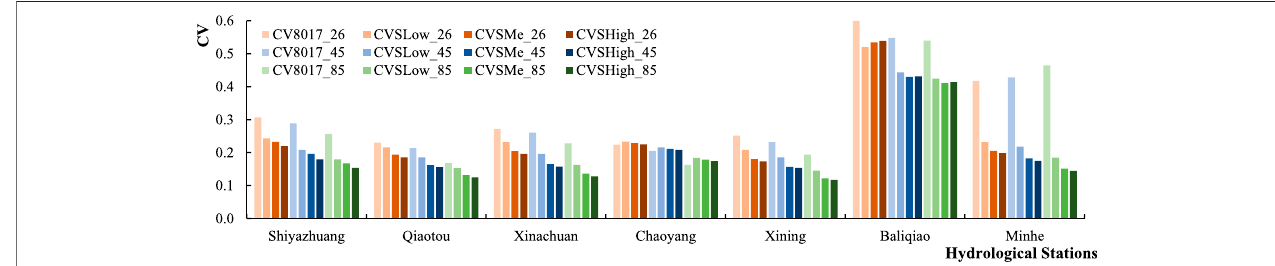
FIGURE 6 | Changes in the coef fi cient of variation (CV) values of annual runoff under different layout schemes and different climate scenarios.